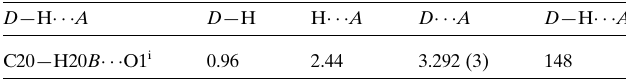
Table 1 Hydrogen-bond geometry (A˚ , (cid:2) ).